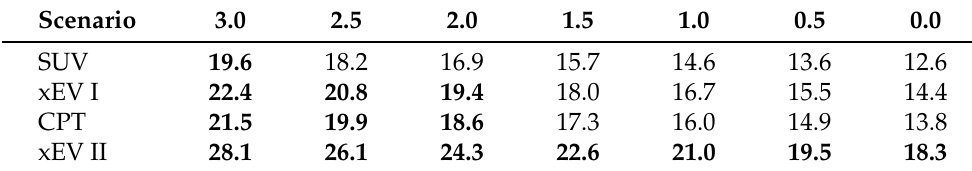
Table 6. 2035 FE